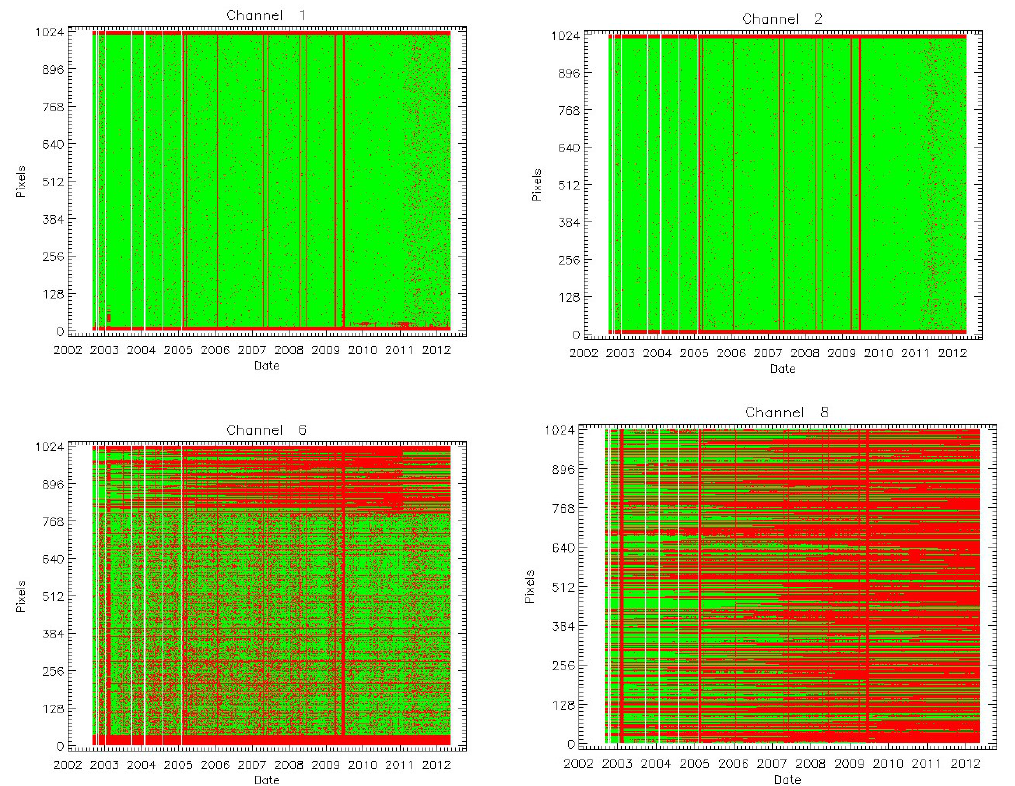
Figure 2. The figures display the distribution of SCIAMACHY 1024-pixel per channel for channels 1 & 2 ( top ) and channels 6 & 8 ( bottom ) over the mission lifetime (2002–2012). Good pixels are shown in green and the flagged bad/dead ones in red. The figures are shown for comparison between the UV/VIS channels 1 & 2 and the SWIR channels 6 &